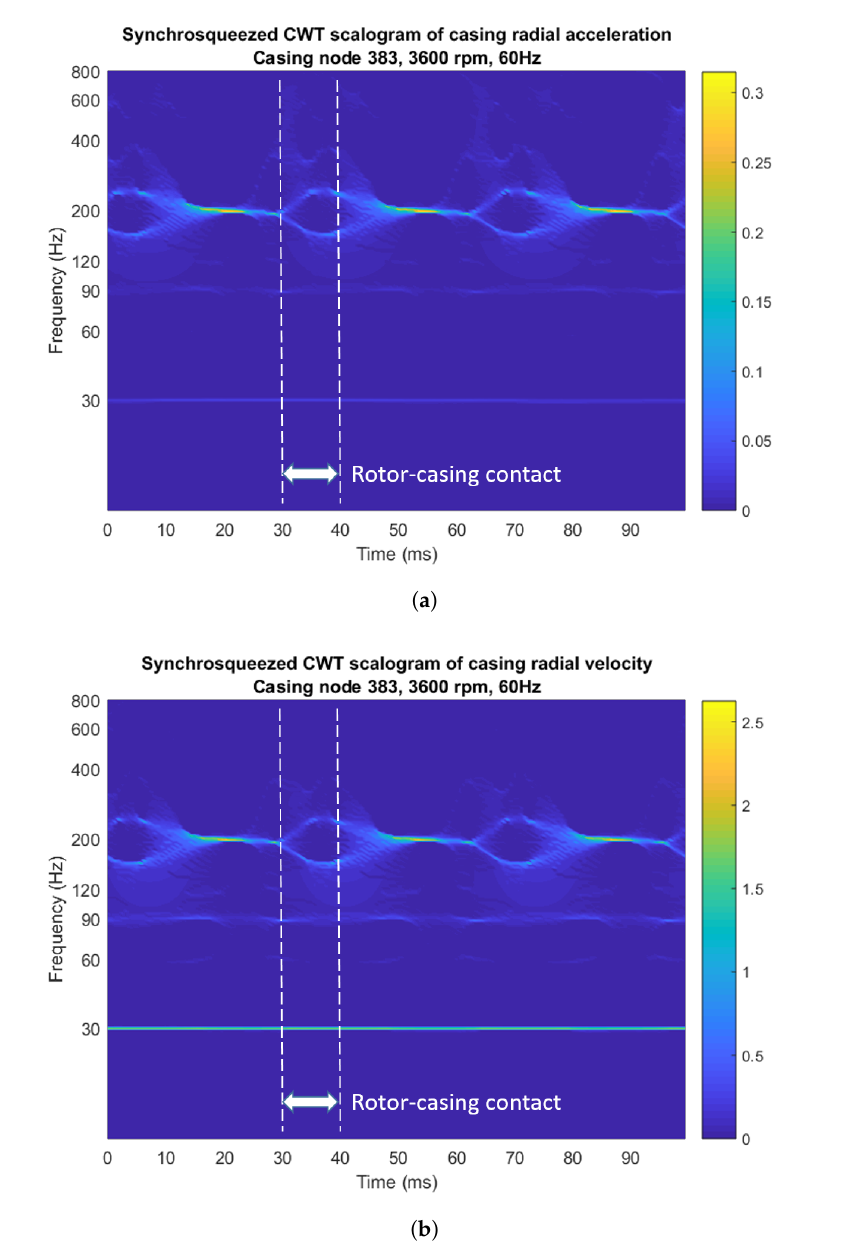
Figure 12. Synchrosqueezed CWT scalograms of the steady-state casing signals with the Morlet wavelet for single-point rub and the frequency axis in logarithmic scale: ( a ) casing acceleration, color scale in g ; and ( b ) casing velocity, color scale in mm/s. The boundaries of one of the rotor–casing rubs are marked with white dotted